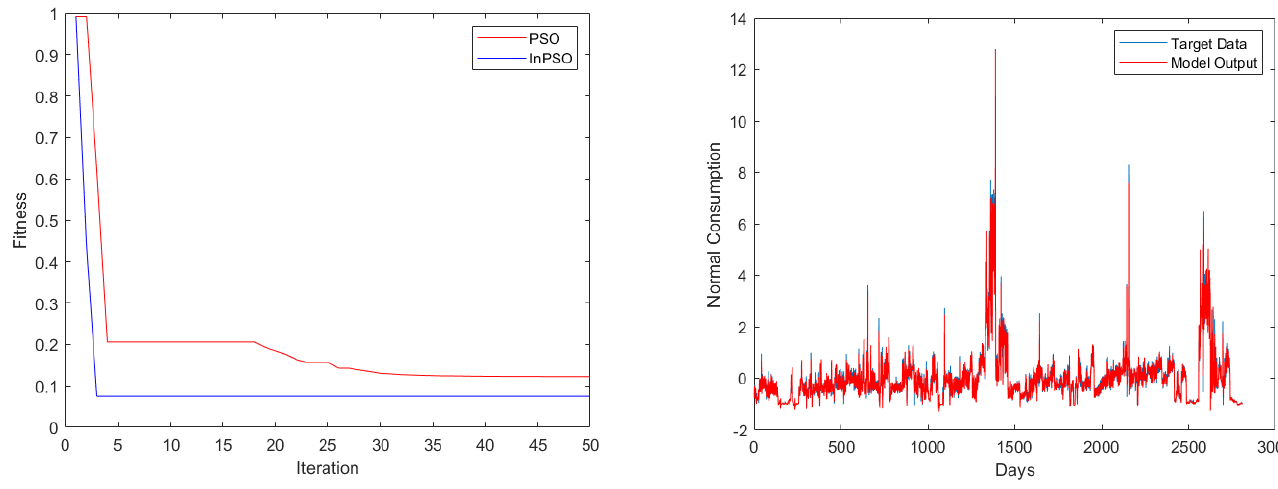
Figure 4. The results of the DNFW prediction for Mashhad’s energy consumption.